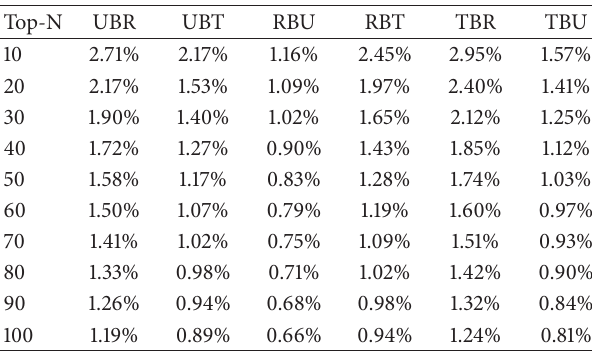
Figure 5: Recall/precision of the six algorithms. Table 3: The score of the SCN.